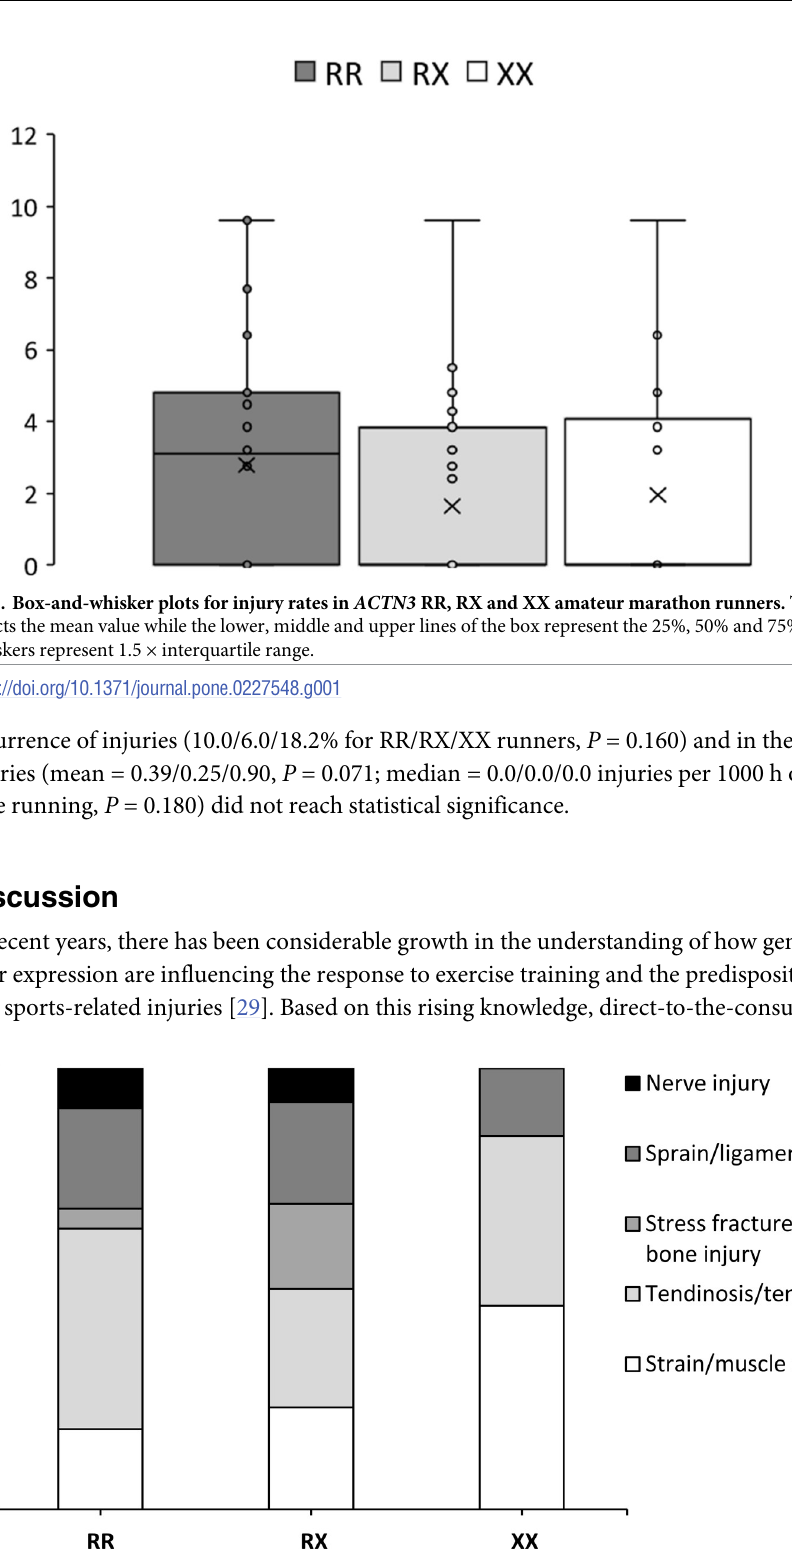
Fig 2. Type of injury in ACTN3 RR, RX and XX amateur marathon runners. Data are the frequency for each type of injury from the total of injuries in each genotype.